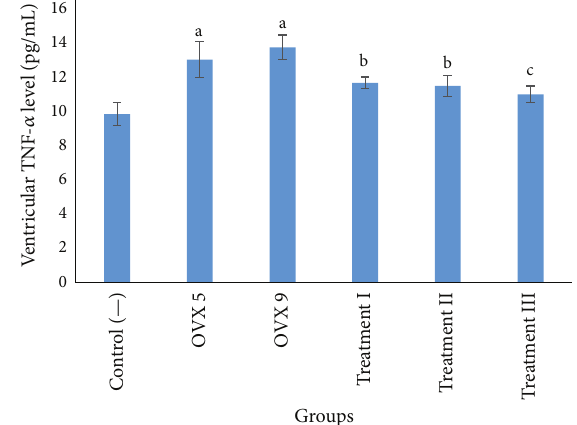
Figure 1: Mean of ventricular TNF- 𝛼 level in each group (pg/mL). a 𝑝 < 0.05 compared to control (—) group and treatment groups; b 𝑝 < 0.05 compared to control (—) and OVX groups; c 𝑝 < 0.05 compared to OVX groups. OVX 5: 5-week ovariectomy; OVX 9: 9-week ovariectomy. Treatments I, II, and III reflected 9-week ovariectomy treated with 500, 1500, and 2500 mg/kgBW ceplukan leaf’s methanolic extract,